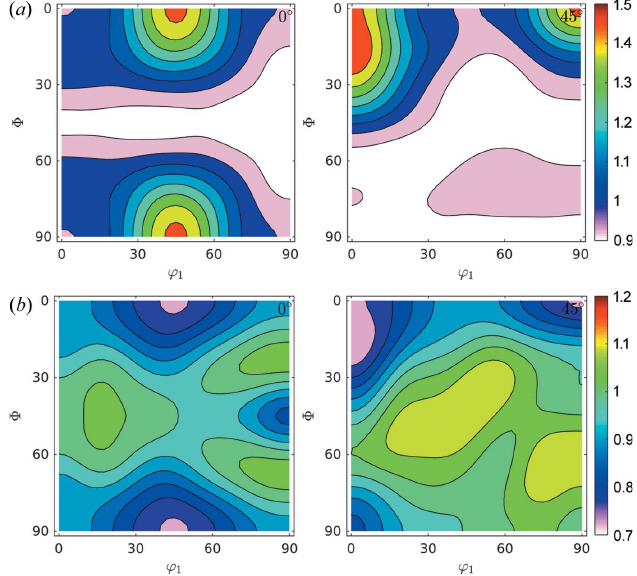
Figure 9 GDFs for doman size and dislocation density at ’ 2 = 0 (cid:6) and ’ 2 = 45 (cid:6) for the IF cold-rolled sample. Comparison with Fig. 6( a ) suggests that the orientation along the (cid:6) -fibre stores more dislocations than other orientations, and that orientations in the (cid:7) -fibre grew larger domains.